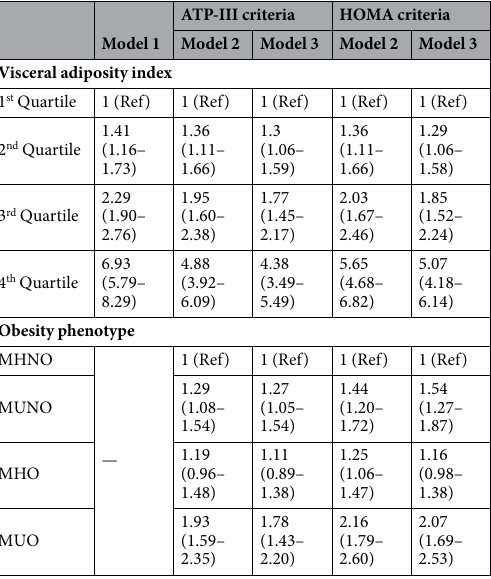
Table 4. Adjusted odds ratios (OR) and 95% confidence intervals (CI) of the presence of hyperuricemia associated with the visceral adiposity index, along with metabolic health and obesity phenotypes defined by ATP-III and HOMA criteria, respectively. Abbreviations : ATP-III, the Adult Treatment Panel-III; HOMA, homeostasis model assessment of insulin resistance; MHNO, metabolically healthy non-obese; MUNO, metabolically unhealthy non-obese; MHO, metabolically healthy obese; and MUO, metabolically unhealthy obese. Model 1: Adjusted for age and sex. Model 2: Adjusted for Model 1 + urban/rural resident, smoking status, alcohol status and metabolic health-obesity phenotypes. Model 3: Adjusted for Model 2 + white blood cell, total cholesterol, blood pressure, glucose and